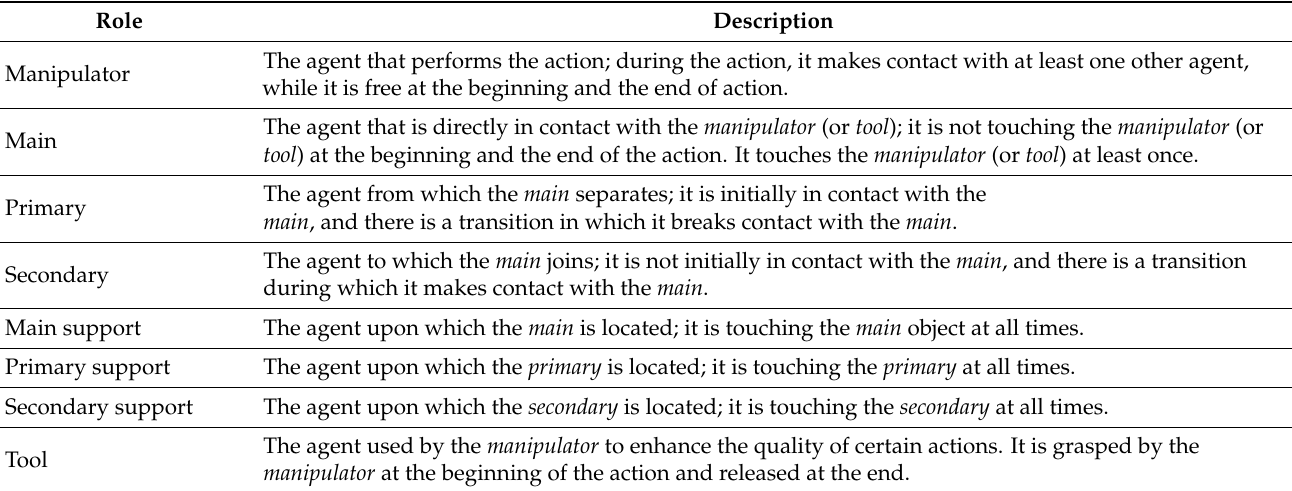
Table 2. Role of the objects in an atomic